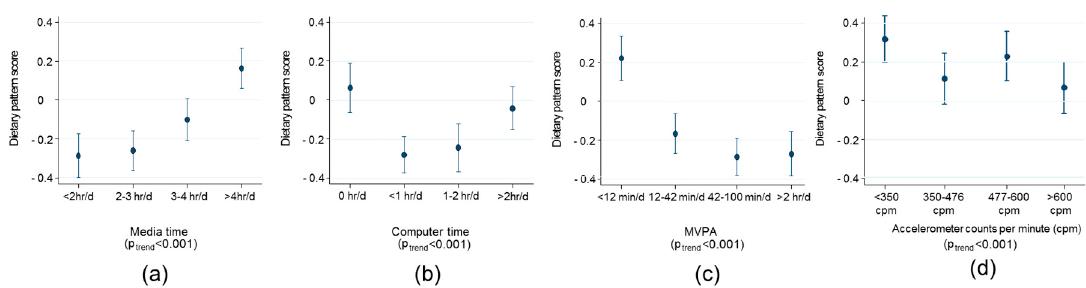
Figure 4. Trends in the obesogenic dietary pattern score among adults (>18 years n = 3549 panel a and b, n = 3790 panel ( c ) and children (aged 11–16 years, n = 861 panel d) by ( a ) media time; ( b ) computer time; ( c ) time spent in moderate to vigorous physical activity (MVPA); ( d ) objectively measured survey-weighted linear regression adjusted for age, gender and daily energy intake. Media time,